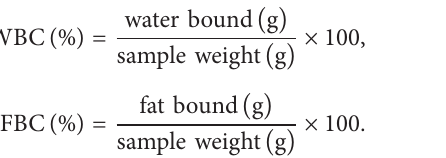
Ubbelohde-type capillary viscometer at 25 ± 1 ∘ C. Then, 𝑀